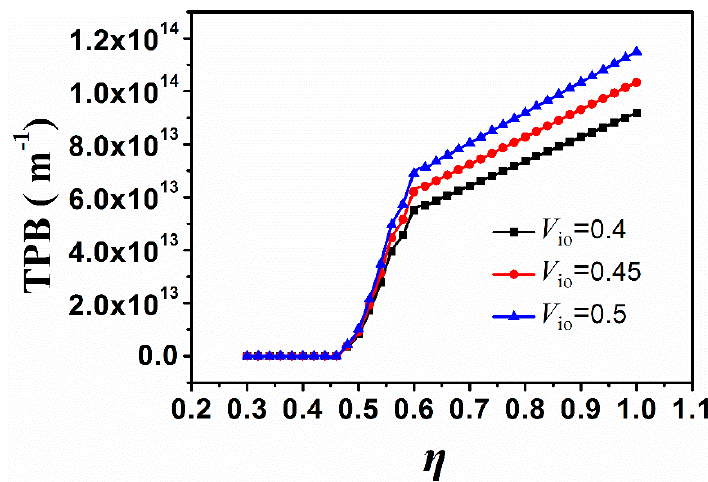
Figure 7. The dependence of triple phase boundary (TPB) length on impregnation loading.